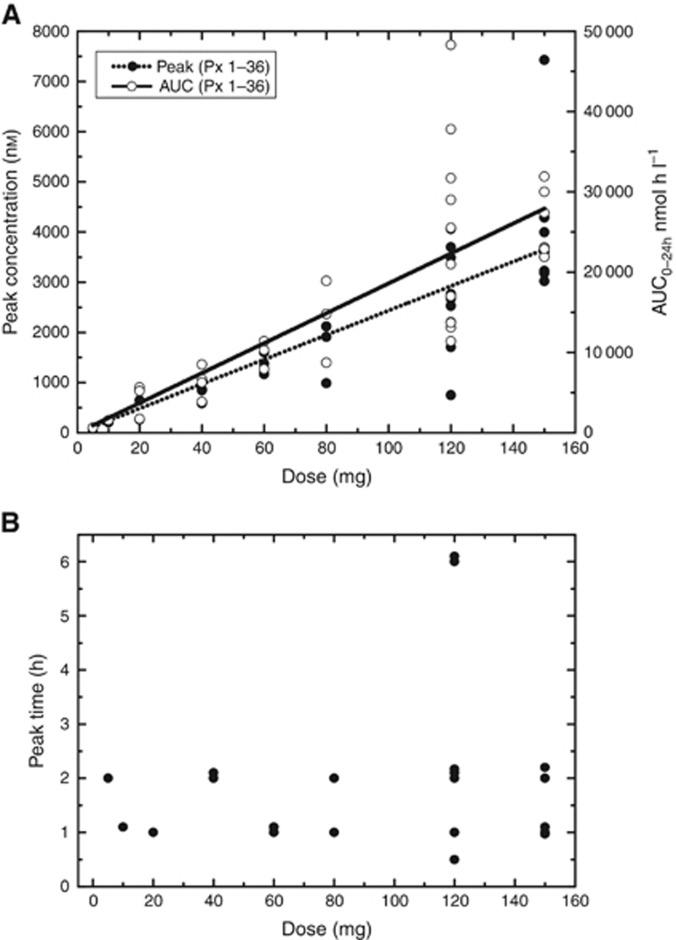
Pharmacokinetic data for once daily dosing of AZD0424. (A) Relationship between AZD0424 dose and peak concentration (Cmax) and AUC(0–24 h) for Cycle 1. (B) Relationship between AZD0424 dose and time to reach peak concentration (Tmax) for Cycle 1.